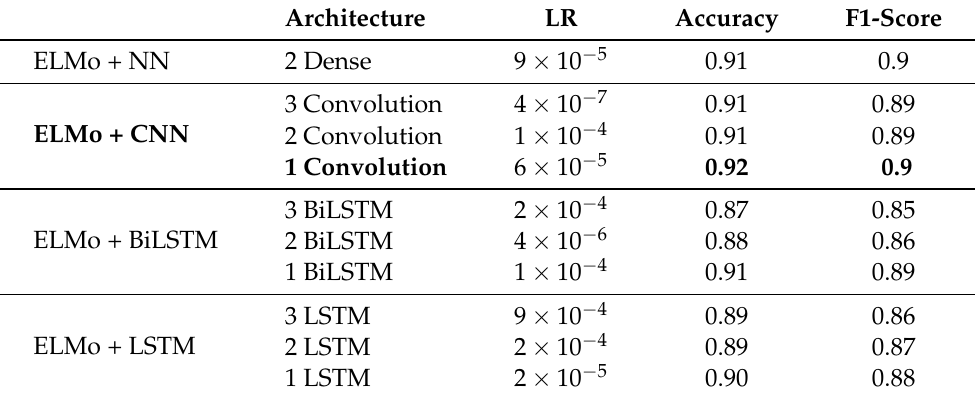
Table 8. Classification using